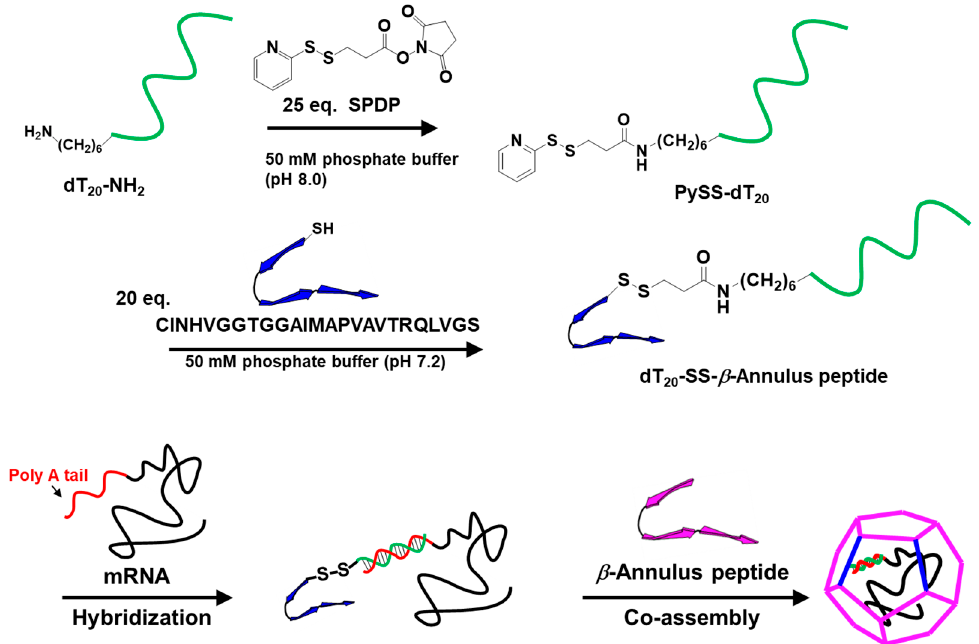
Figure 1. Schematic of synthesis of dT 20 modified β -annulus peptide (dT 20 -SS- β -annulus) and formation of an artificial viral capsid by co-assembly of β -annulus peptide and dT 20 -SS- β -annulus hybridized with mRNA.